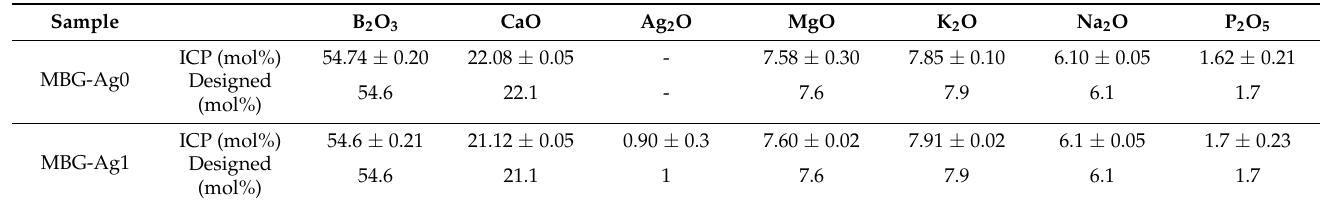
Table 2. Ion release concentrations of the synthesized Ag-free and Ag-doped 1393B3